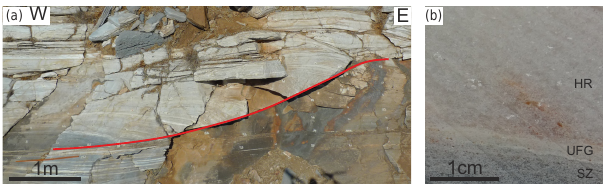
Figure 1. (a) Image presenting the studied flanking structure on Syros. The red line traces the cross-cutting element (i.e. shear zone). (b) Close-up of the boundary between the shear zone (SZ) and host rock (HR) showing a thin layer that is ultra-fine-grained (UFG) and white in